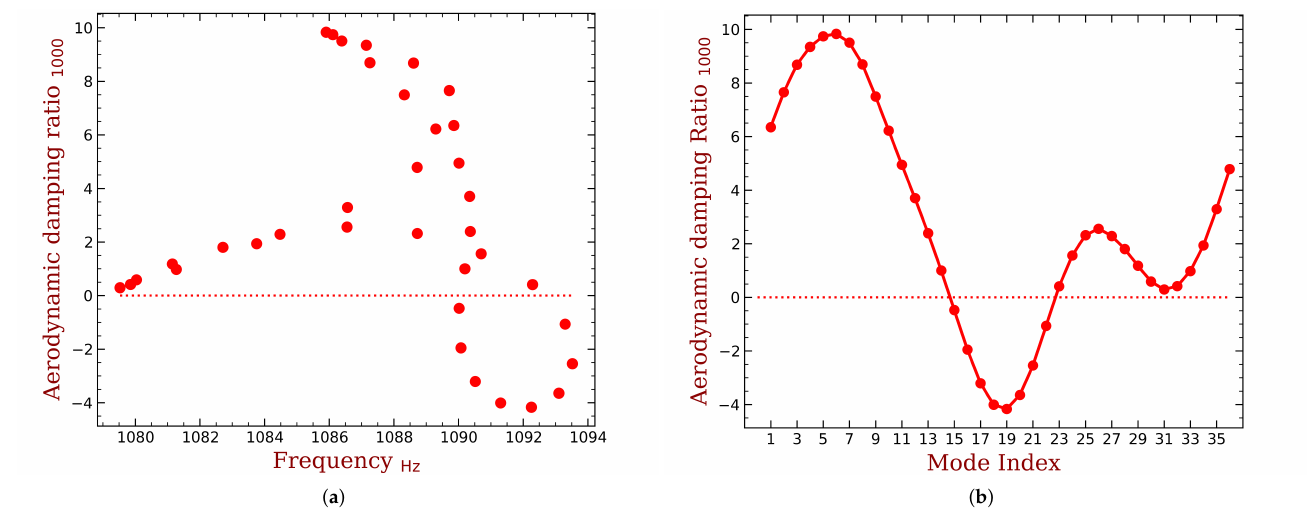
Figure 6. Aerodynamic damping ratios of the tuned bladed disk. The mapping between the modal index and NDI is shown in Equation (4). ( a ) Sorted by frequency, ( b ) sorted by modal